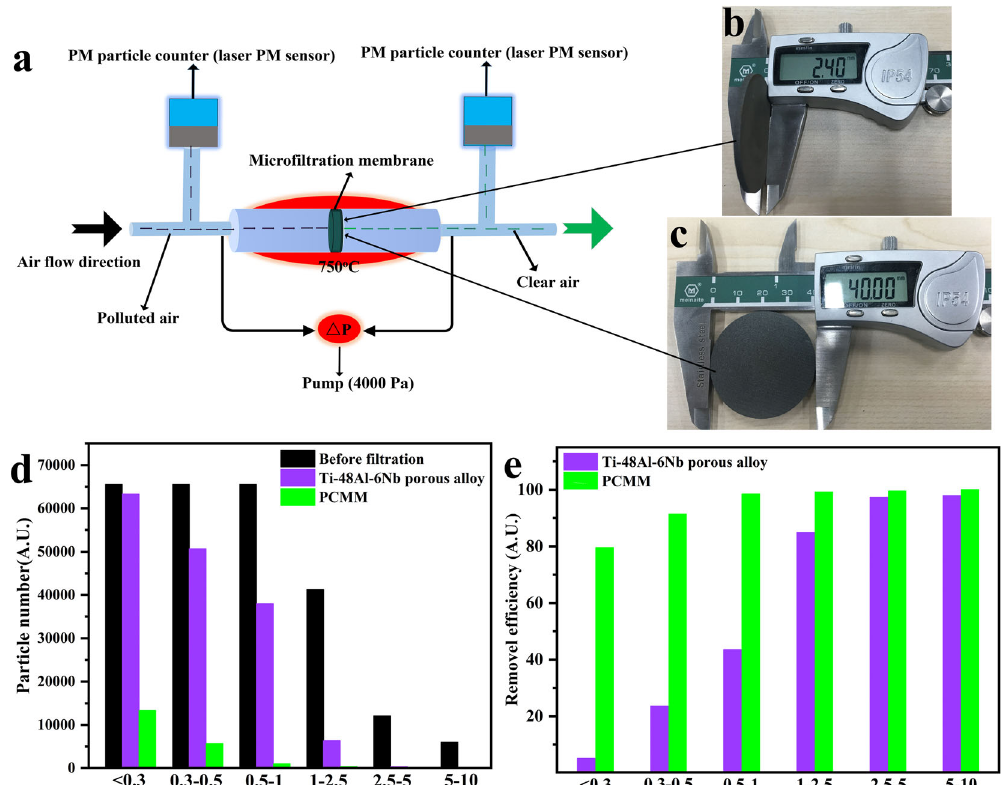
Fig. 9 High-temperature fi ltration performance test of porous sample. a Schematic of high-temperature PM fi ltration setup. b , c The pictures of PCMM sample; d PM concentration of dust-laden smoke (original) and after fi ltration under test condition; e removal ef fi ciency.